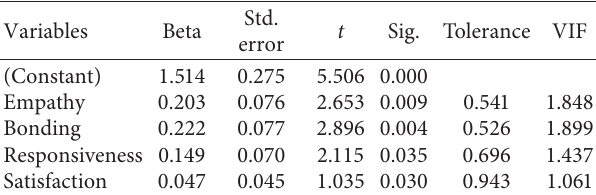
Table 6: Results of the regression